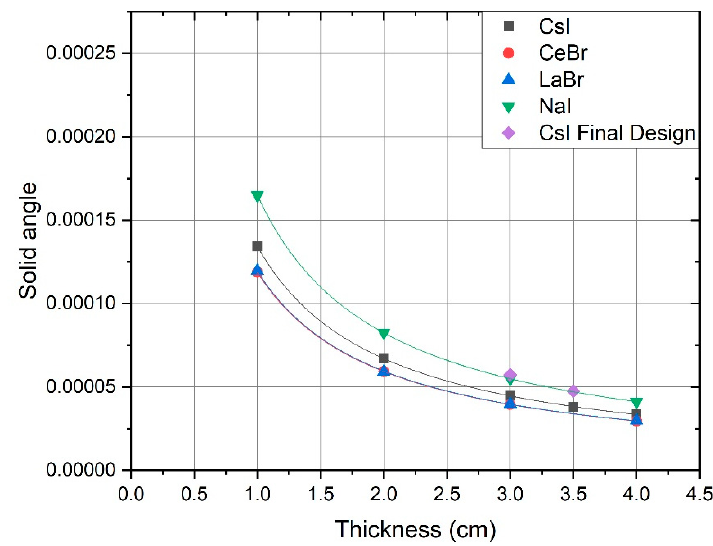
Figure 5. Results of Monte Carlo simulations using Penelope (2018). Different detector materials and geometries with a mass of 1 kg (all except Final Design) compared to the solid angle of an isotropic Co-60 point source.